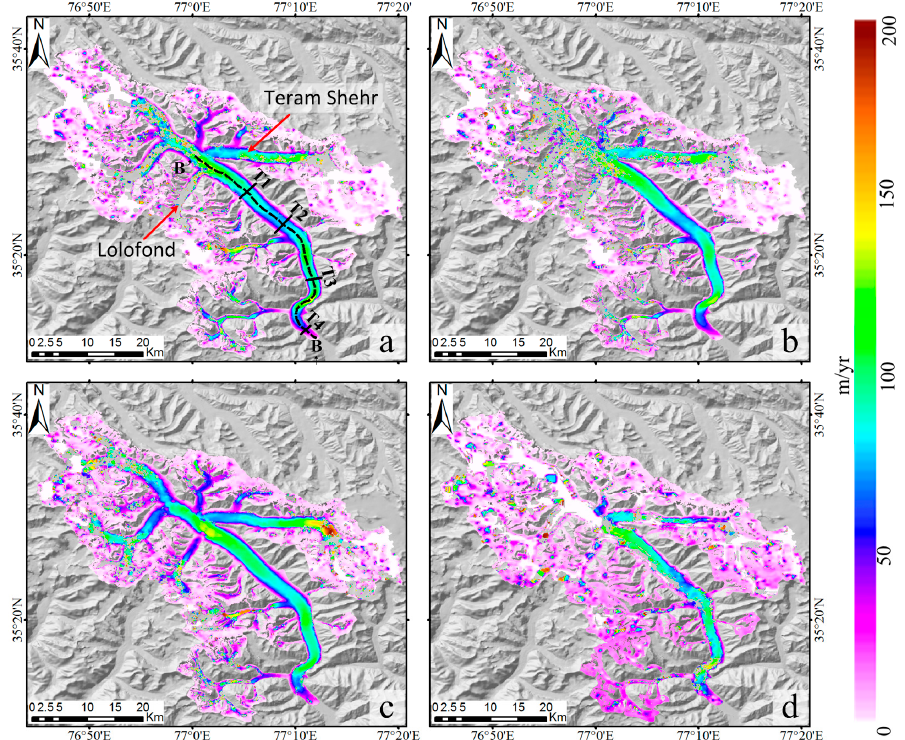
Figure 5. Four annual velocity fields of the Siachen Glacier and its tributaries from 1999–2003. ( a ) 1999–2000; ( b ) 2000–2001; ( c ) 2001–2002; and ( d ) 2002–2003. The background is the hillshade image of SRTM DEM. BB’ is the centerline of the glacier, and T1, T2, T3, and T4 are the transverse profile’s locations.